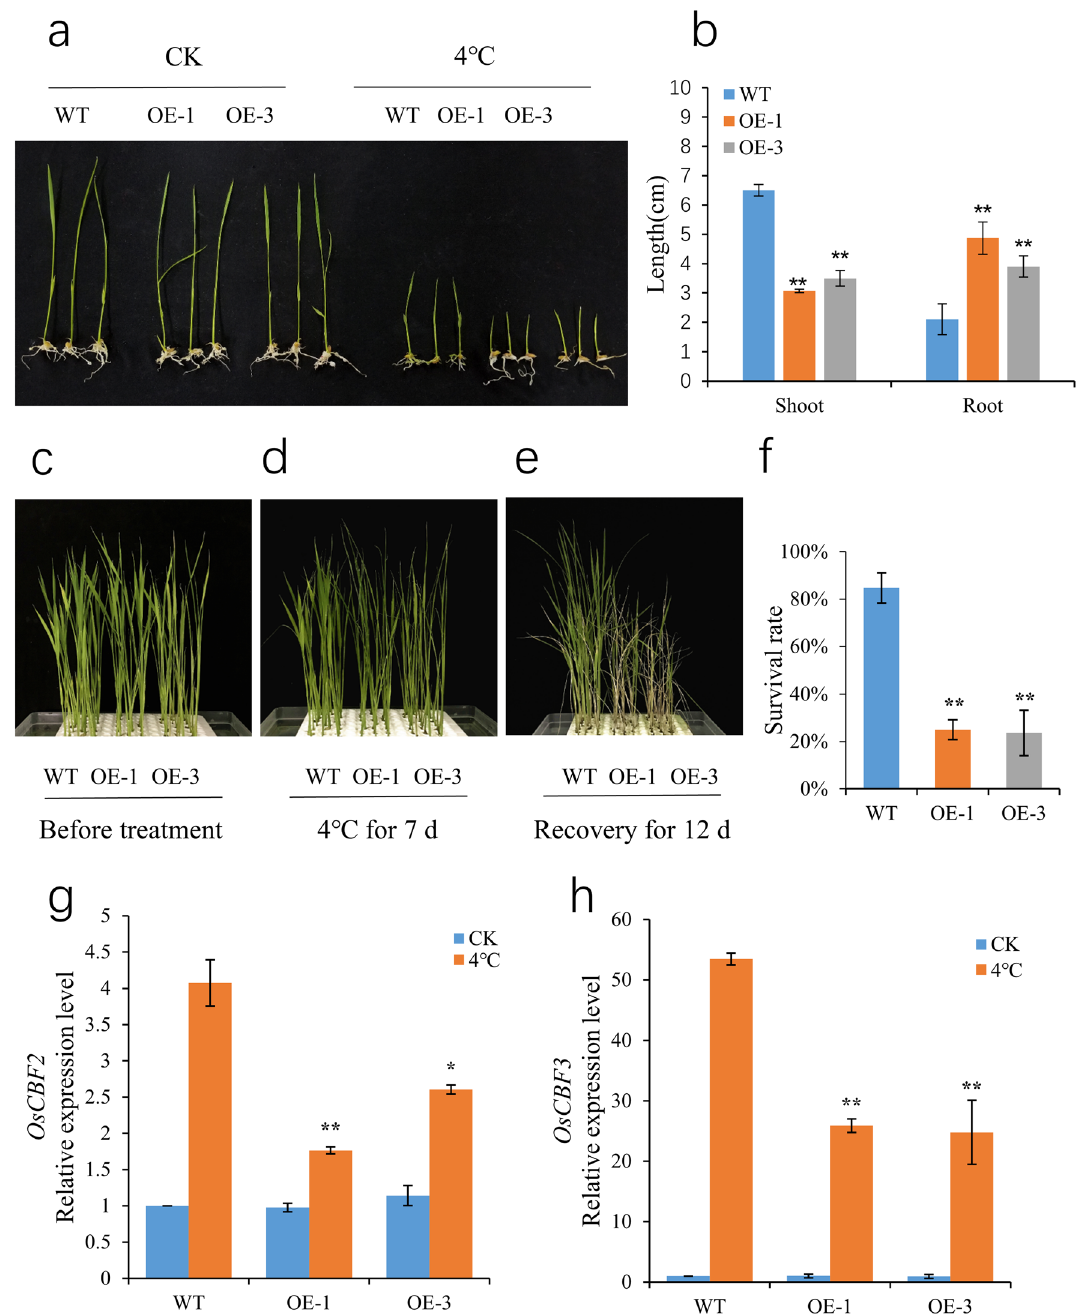
Figure 3. Effects of cold stress in wild type (WT) and OE lines. ( a ) Phenotypes of WT and OE lines under 4 °C for 3 days. ( b ) Plant height and root length of WT and OE lines treated at 4 °C for 3 days. ( c ) Phenotype of WT and OE lines hydroponically cultivated for 14 days (before imposition of the cold stress). ( d ) Phenotypes of WT and OE lines treated for 7 days at 4 °C. ( e ) Phenotypes of WT and OE lines after 12 days recovery following the 4 °C treatment. ( f ) Survival of recovered WT and OE lines. ( g – h ) The expression levels of OsCBF2 and OsCBF3 were analyzed after two days of treatment at 4 °C, respectively. Error bars represent ± SE (n = 3). Asterisks indicate significant differences between transgenic lines and WT ( * P < 0.05, ** P < WT seedlings under normal growth conditions, but high salt inhibited the growth of OsSCL30-OE seedlings (Fig. 5a). After salt treatment, both plant height and root length of OsSCL30-OE seedlings were significantly shorter than those of WT (Fig. 5b). We cultured 14-day-old Nip (WT) and two overexpressing lines (OE-1, OE-3) in 150 mM NaCl for 6 days and then allowed them to recover for 12 days. The results showed that wilting after 6 days of 150 mM NaCl treatment